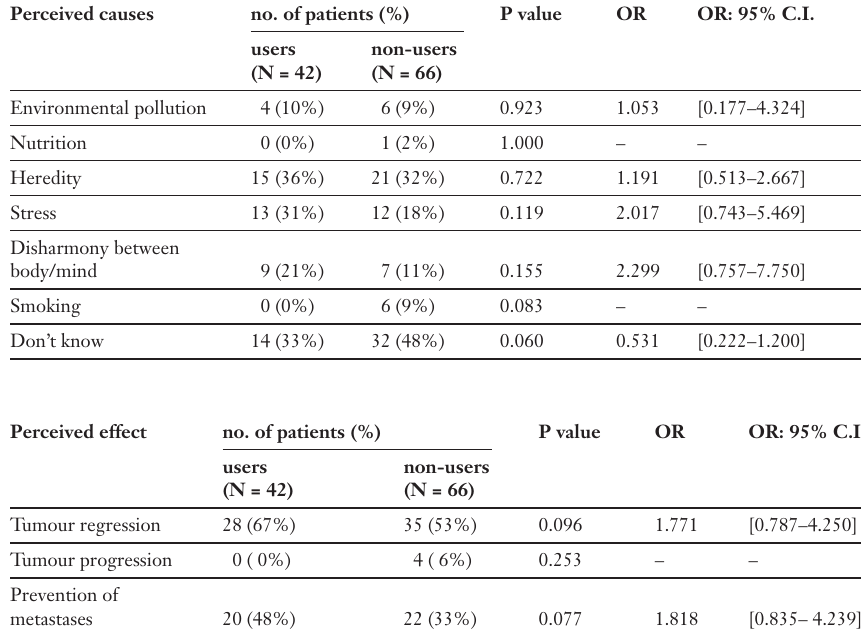
Perceived causes of cancer.